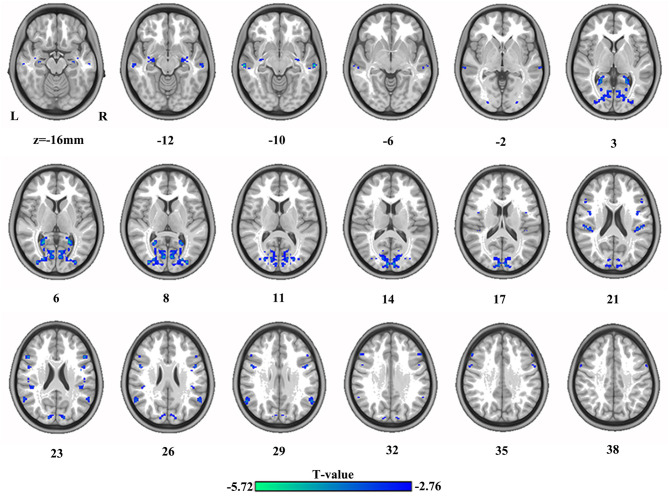
The differences in brain regions in VMHC between HC and SBG patients. The comparison between the two groups was acquired by a two-sample t-test (corrected with AlphaSim for multiple comparisons: voxel-wise p < 0.001 and lesions were excluded within the mask). Decreased VMHC values in SBG patients are represented by cool tones. SBG patients, stroke patients with basal ganglia damage; HC, healthy controls; VMHC, voxel-mirrored homotopic connectivity; L, left; R, right.